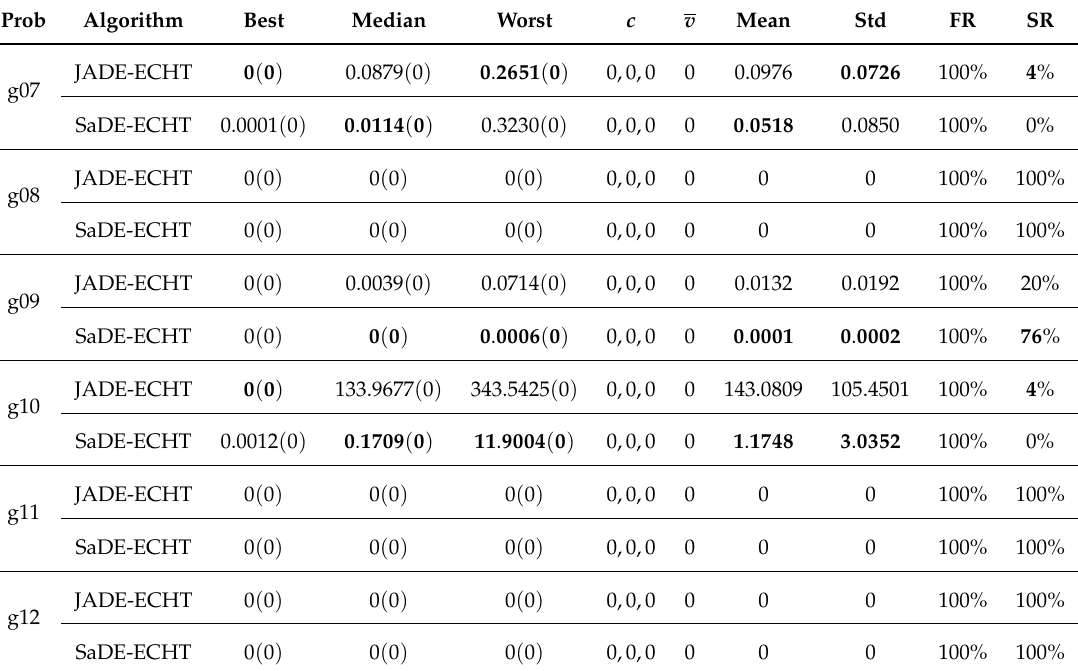
Table 4. Comparison of JADE-ECHT and SaDE-ECHT after FES = 500,000 for g07–g12. The bold numbers indicate the better results.